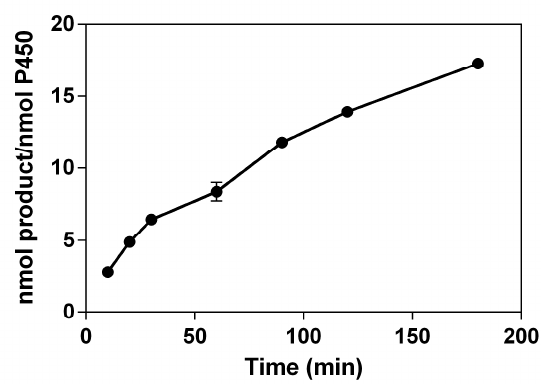
Figure 4. Time profiles of 3 ‐ OH phloretin formation via HLMs. Total turnover numbers (TTNs) for